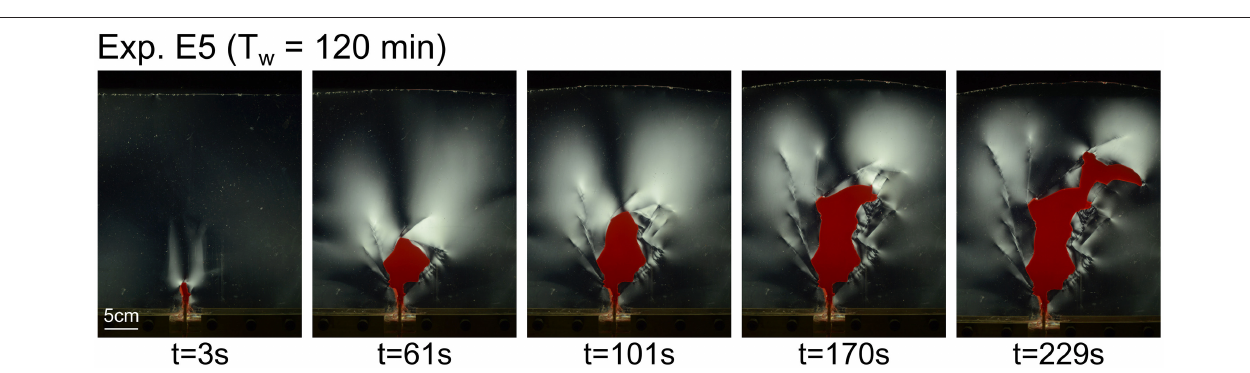
comparison between the contours evolutions of experiments E2 and E7 is essential to highlight subtle, but essential,